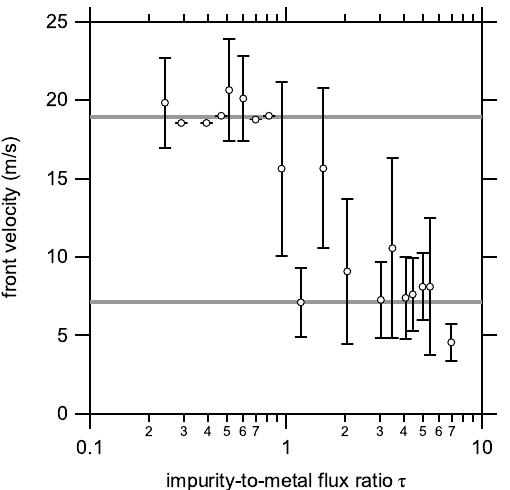
Figure 4. The front velocity of the thermite reaction as a function of the impurity-to-metal flux ratio τ . The two gray lines indicate the weighted average of the two observed